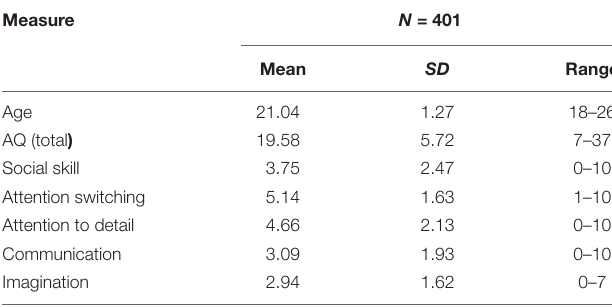
TABLE 1 | A summary of the demographic information in the present study.